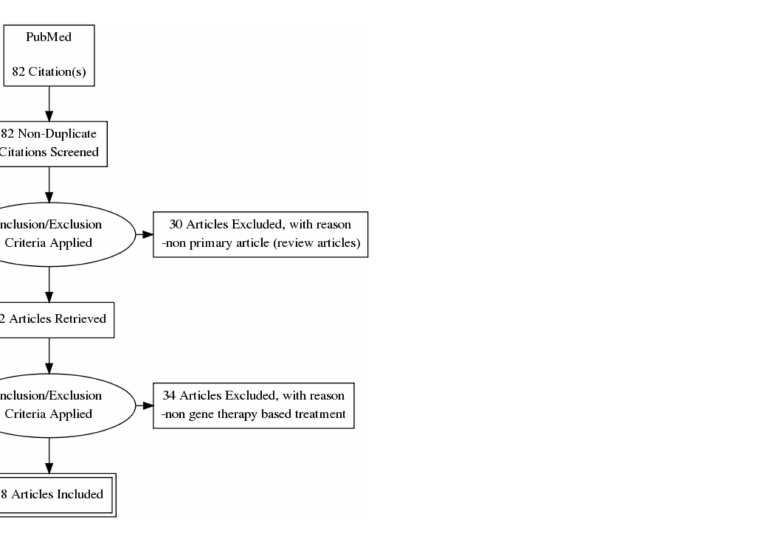
Figure 1. Preferred reporting items for systematic reviews and meta-analyses (PRISMA) flowchart illustrating the selection process of the